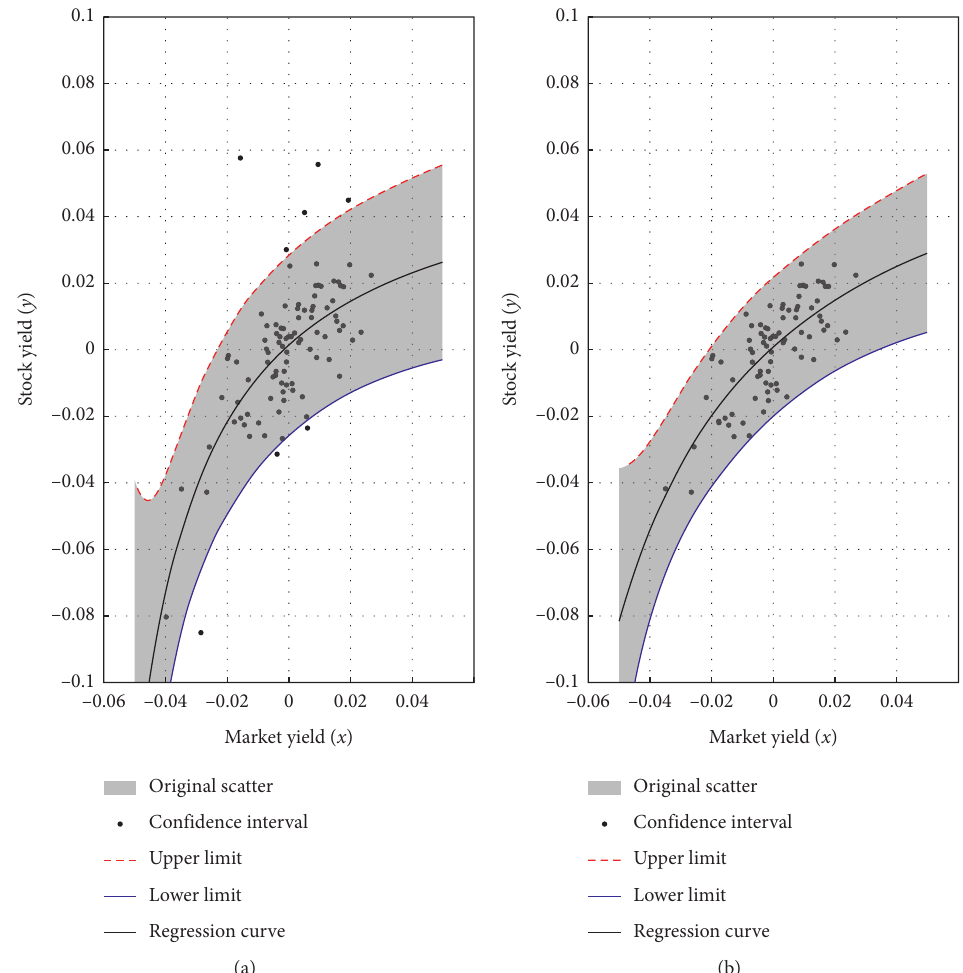
Figure 4: Unary nonlinear model fitting map. (a) Before eliminating abnormal value. (b) After eliminating abnormal